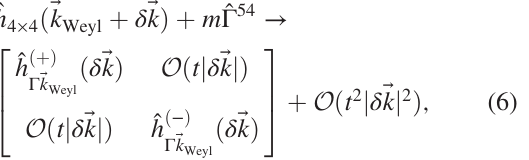
ffiffiffi p 3 ; 1 =